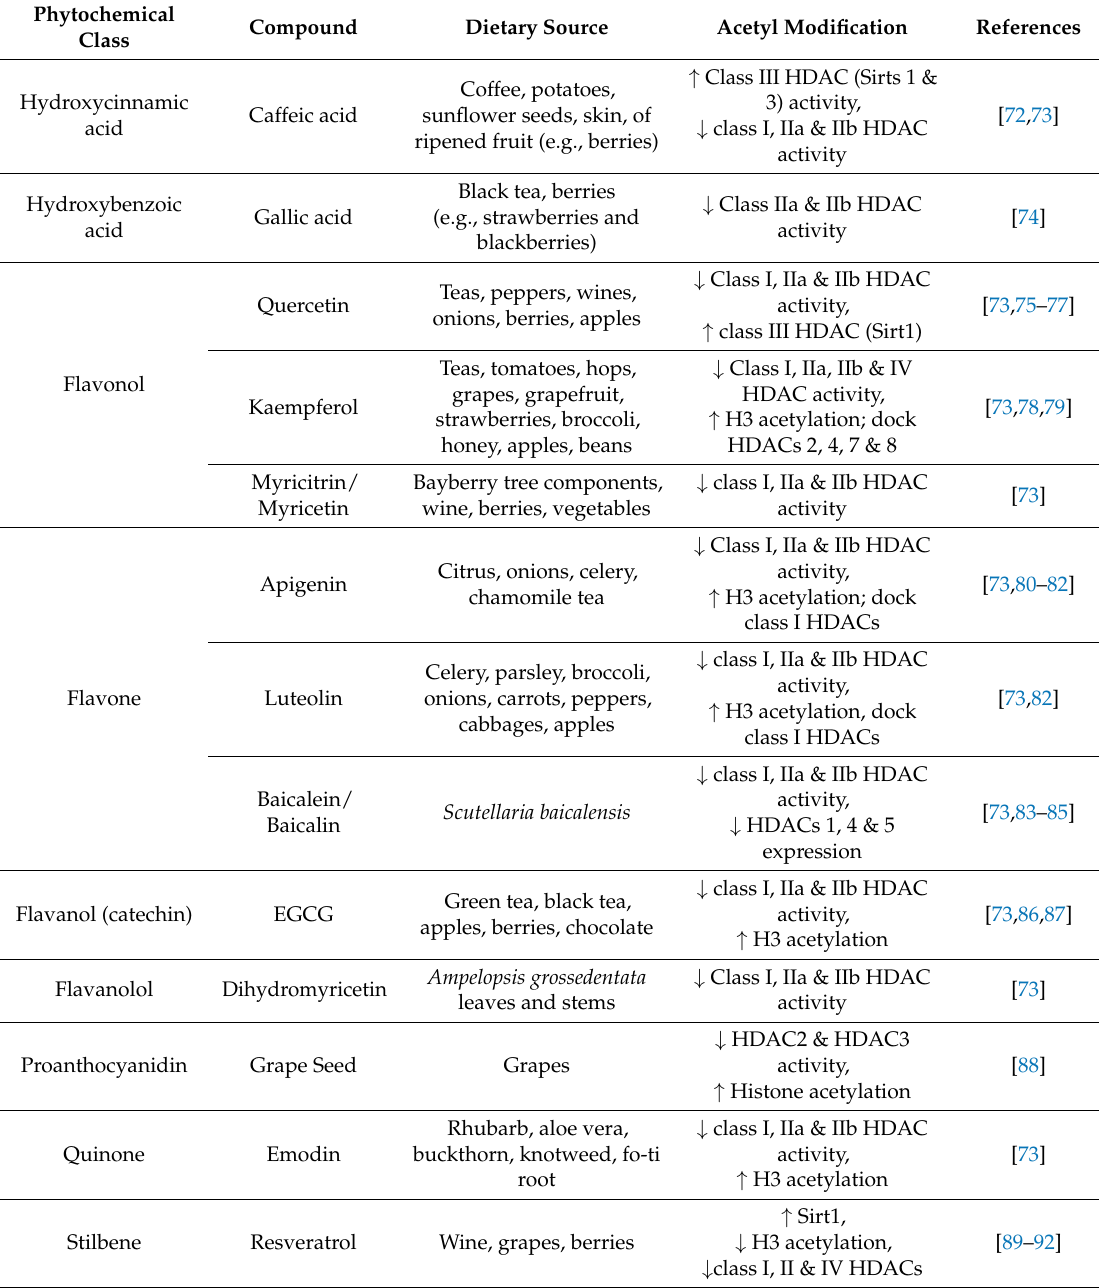
Table 1. Examples of dietary compounds that regulate histone